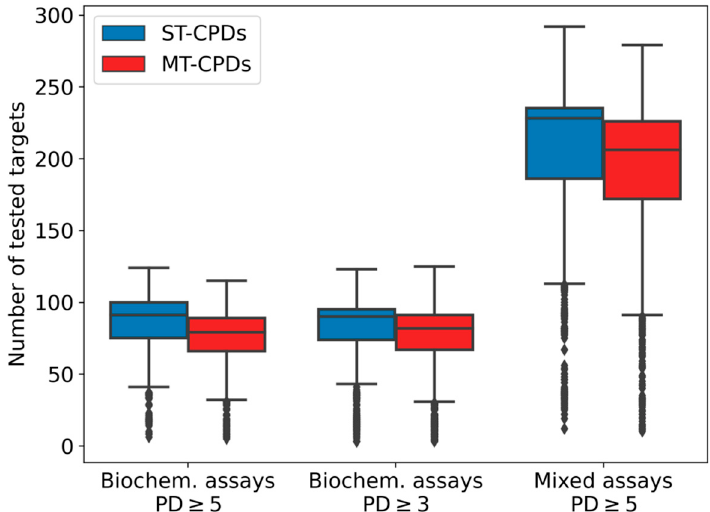
Figure 1. Test frequency of selected compounds. Box plots report the distributions of target-based compound test frequencies for single-target (ST, blue) and multi-target (MT, red) compounds from different datasets. Box plots show the smallest value (lower whisker), lower quartile (lower boundary of the box), median (horizontal line in box), upper quartile (upper boundary of the box), and the maximum value (upper whisker). Values classified as statistical outliers are represented as diamonds.